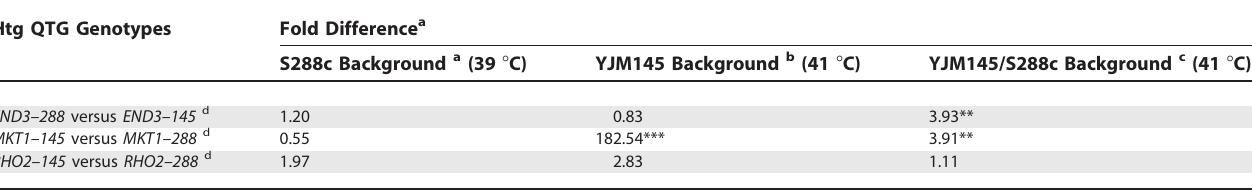
Table 3. Growth Difference between Coding Allele Exchange Strains for Htg Genes in the S288c, YJM145, and YJM145/S288c Hybrid Backgrounds